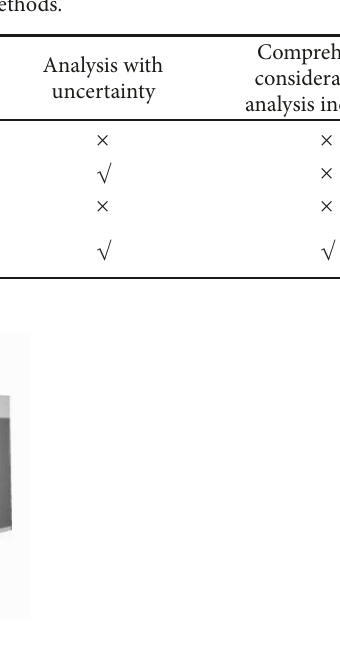
Table 3: Attribute comparison of fault analysis methods.